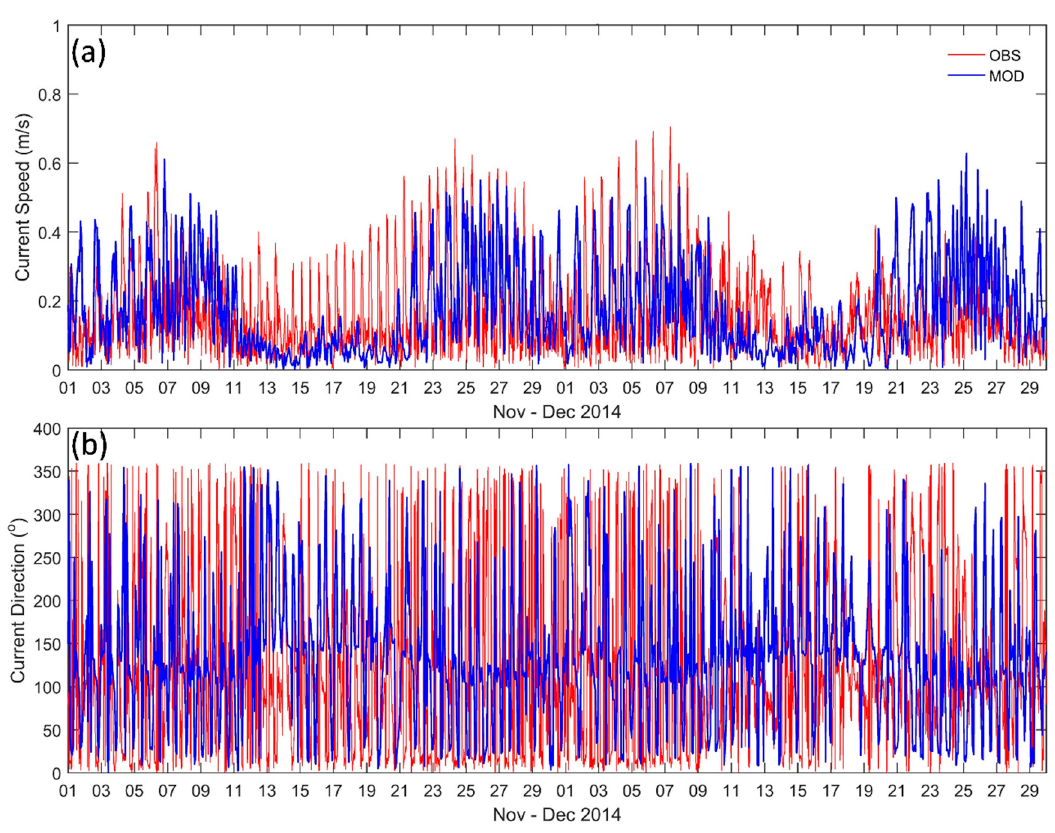
Figure 13. Modeled and measured results located at the ADCP/DVS ocean current mooring site marked in Figure 8 for near-bottom ocean current ( a ) speeds and ( b ) directions at the depth of 196 m.